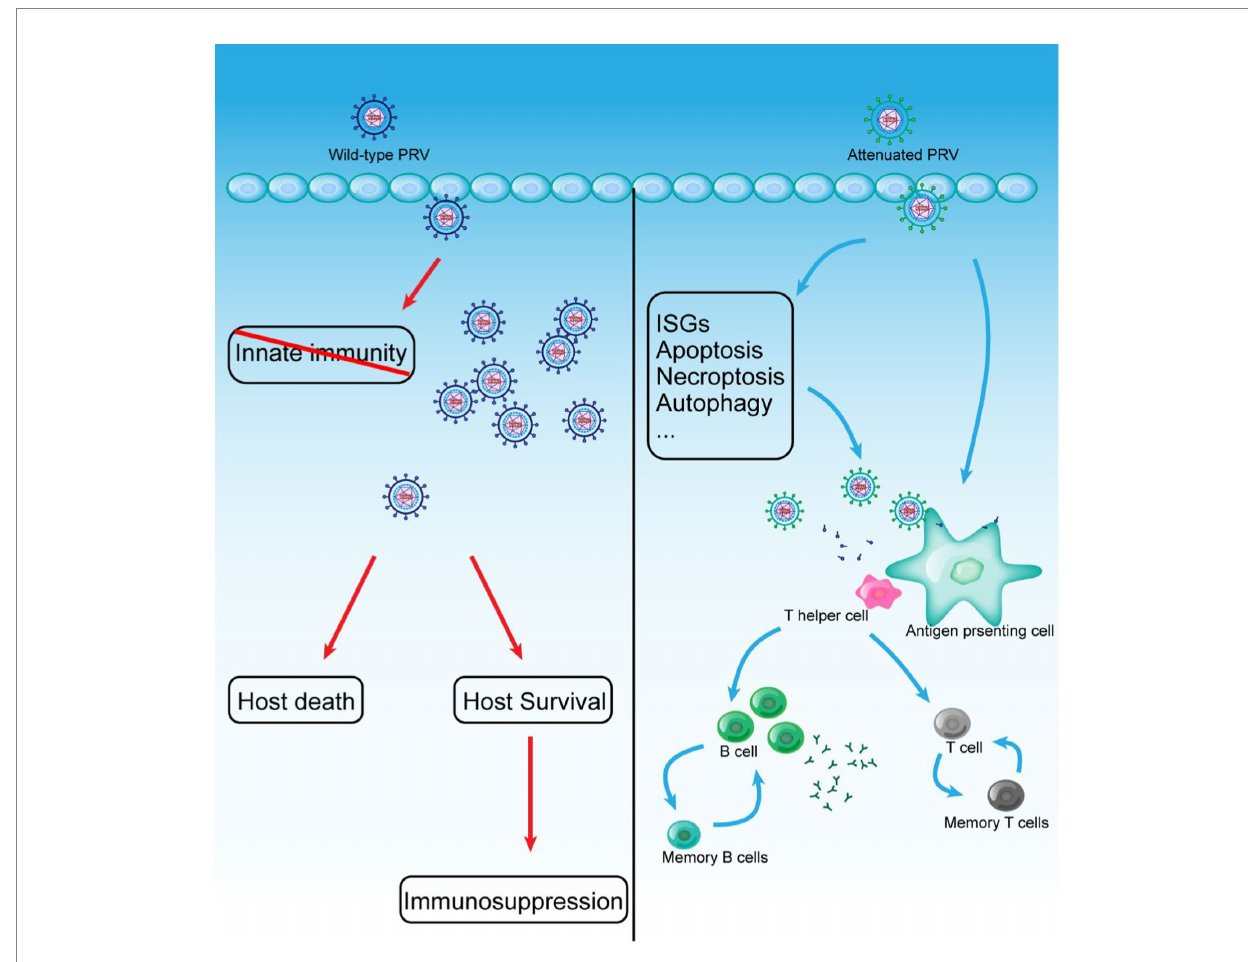
FIGURE 2 WT PRV and Live attenuated vaccines induce the establishment of adaptive immunity in vivo